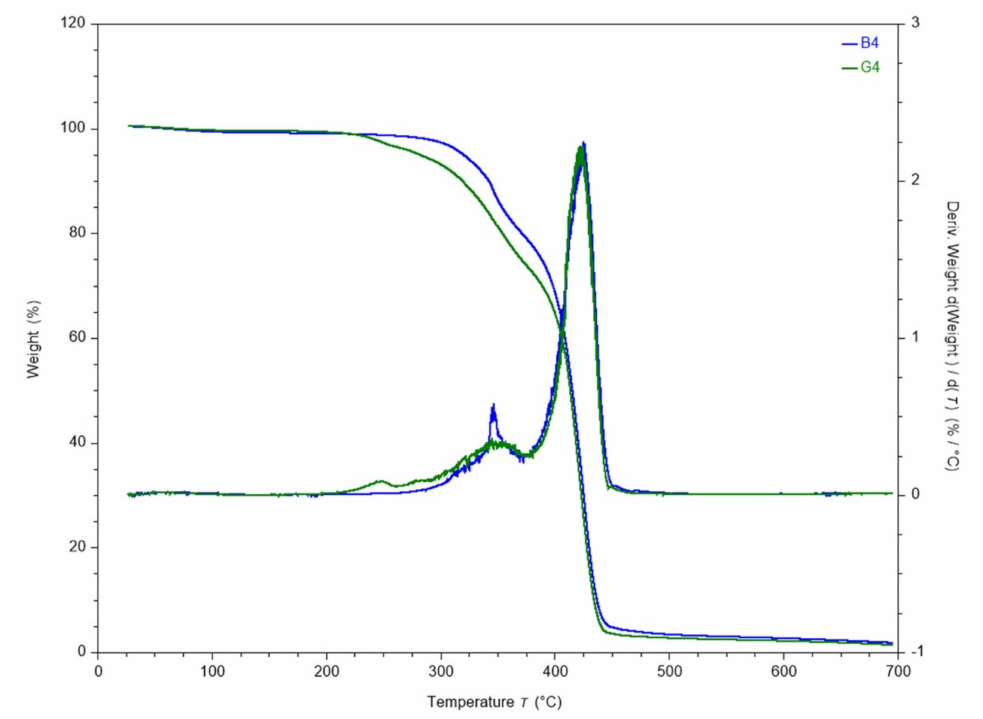
Figure 5. Overlapped thermal degradation curves for the B4 and G4 hydrogel